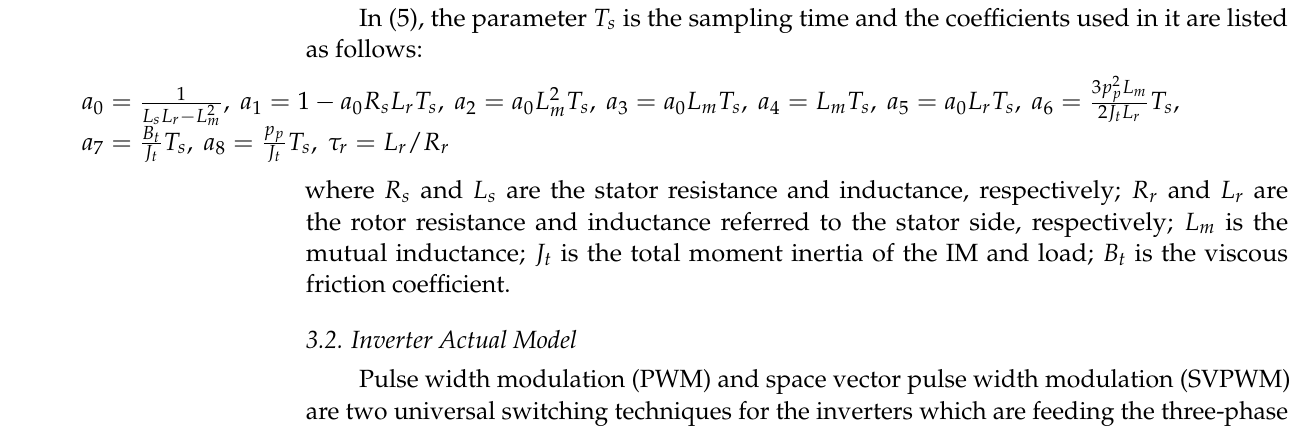
Figure 3. Voltage space vectors based on the SVPWM implemented on TMS320C24x/F24x. The A-phase corresponding switching time delays analysis is shown in Figure 4. The overall principles of the B and C-phase bridge legs is similar to the A-phase. Figure 4 shows the ideal switching signals for the upper ( + ideala T _